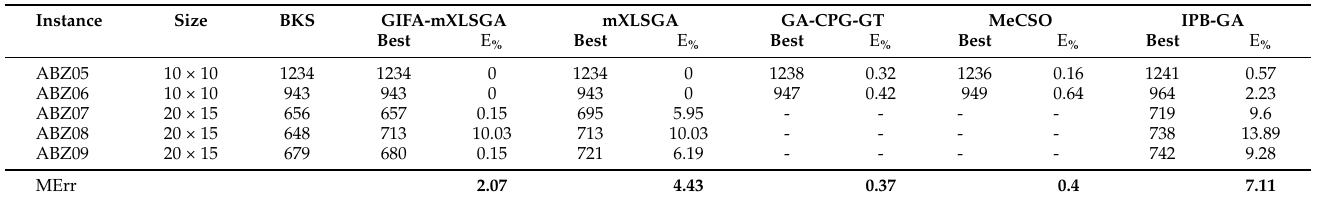
Table 5. Comparison of computational results between GIFA-mXLSGA and other algorithms for ABZ. The symbol “-” means “not evaluated in that